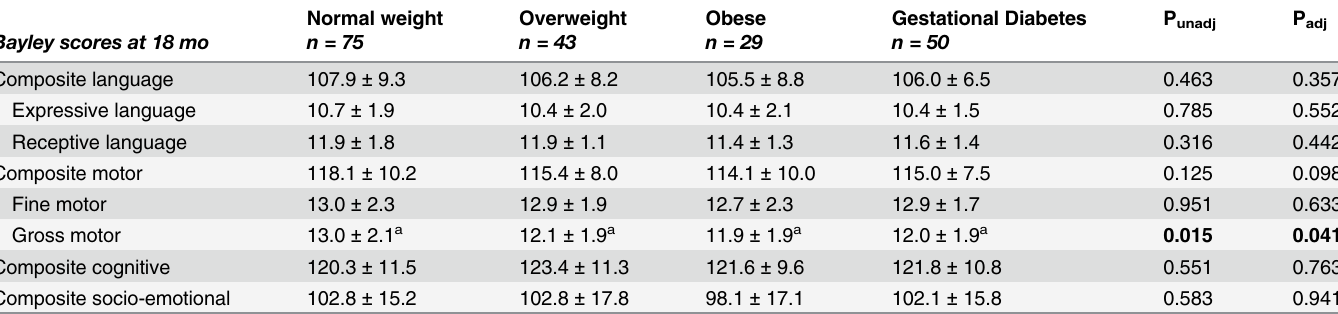
Table 3. Effects of maternal pre-pregnancy overweight, obesity or gestational diabetes on infant ’ s Bayley scores 1 at 18 months of age compared to those born to healthy normo-weight pregnant women (controls). Normal